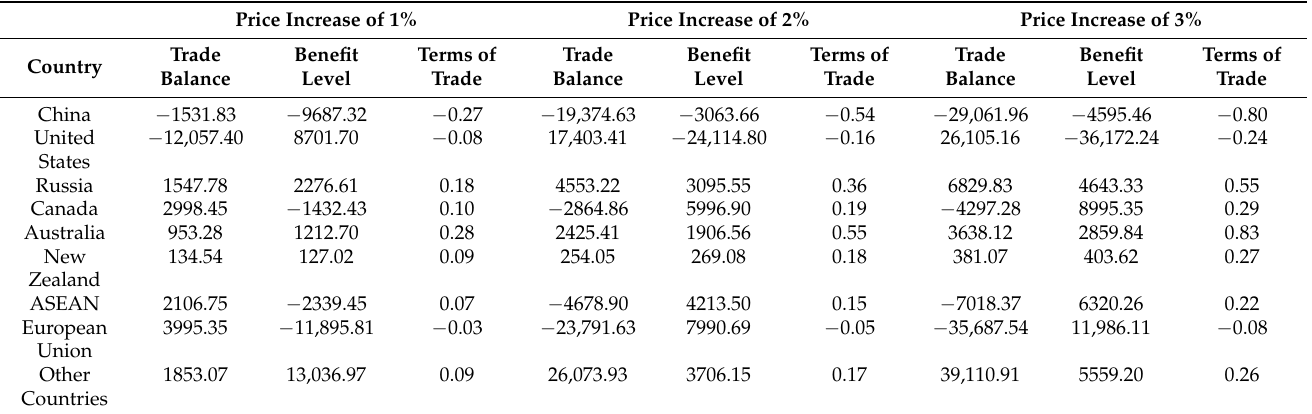
Table 9. Impact of price changes on welfare and trade across